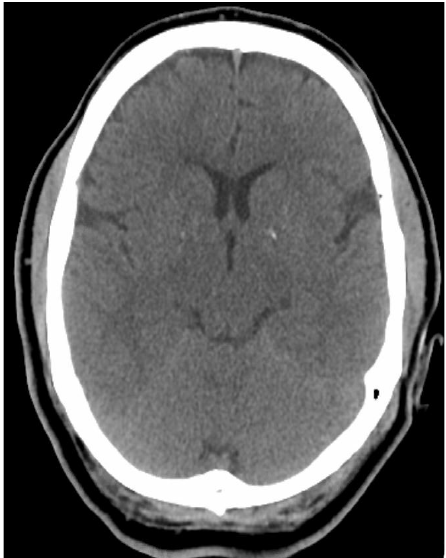
Image 1. Computed tomography scan of the brain without contrast obtained hours earlier without evidence of globus pallidus